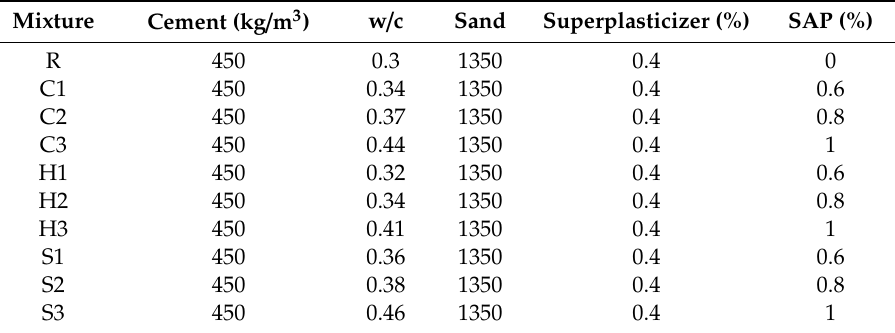
Table 3. Optimized mixture